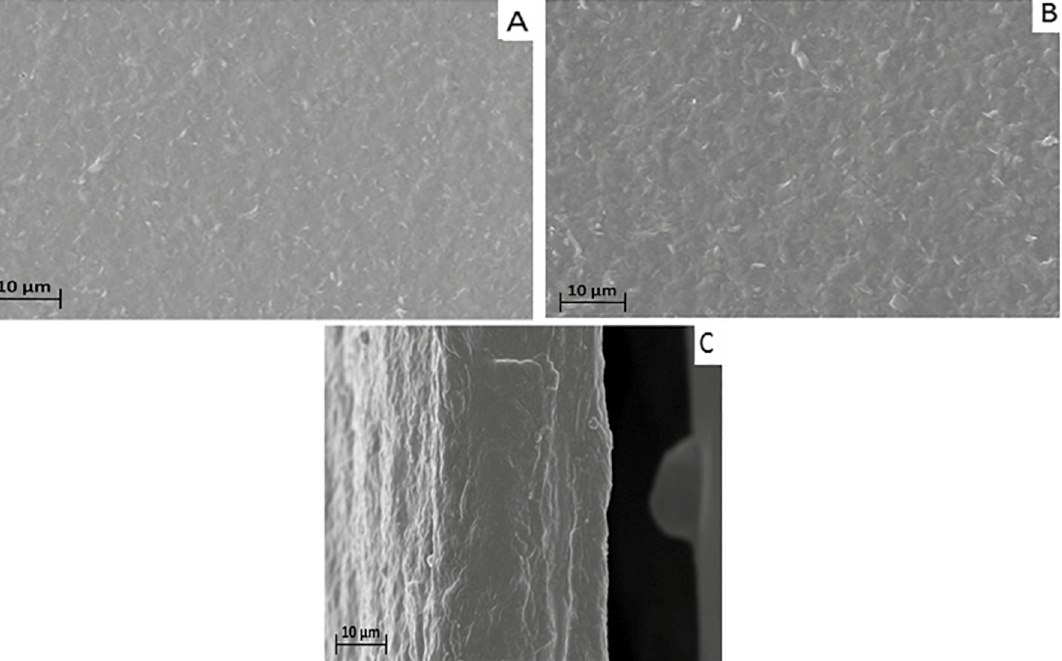
Figure 4. SEM images of (a) PAA/10%SWy-1 and (b) PAA/30%SWy-1, transversal section of the nanocomposite film (c) PAA/30%SWy-1.